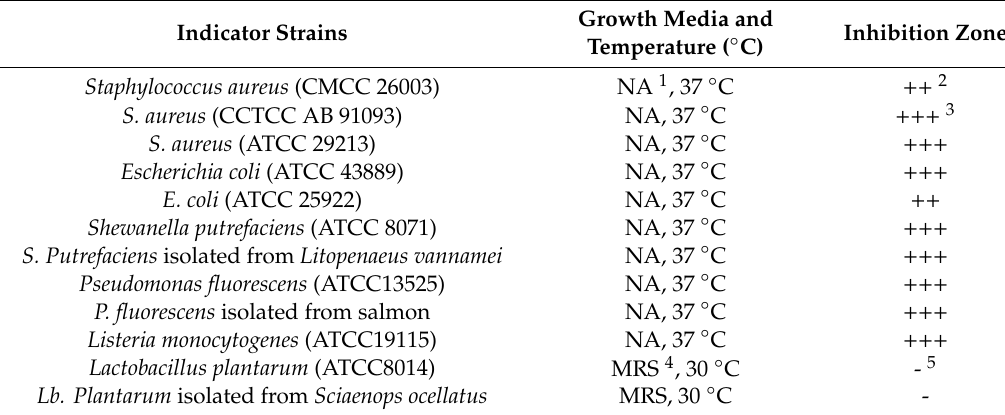
Table 1. Antimicrobial activity of bacteriocin EFL4 from Enterococcus faecalis L04. Indicator